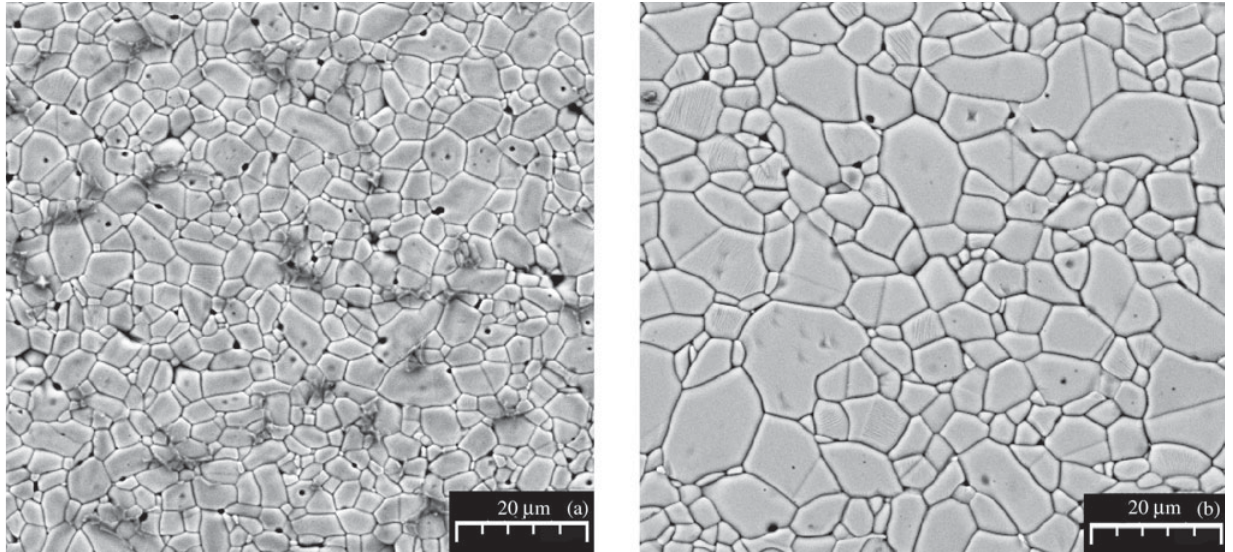
Figure 3. SEM micrographs of the SMNb0.05% composition sintered at 1300 °C for: (a) 1 h; (b) 4 h.